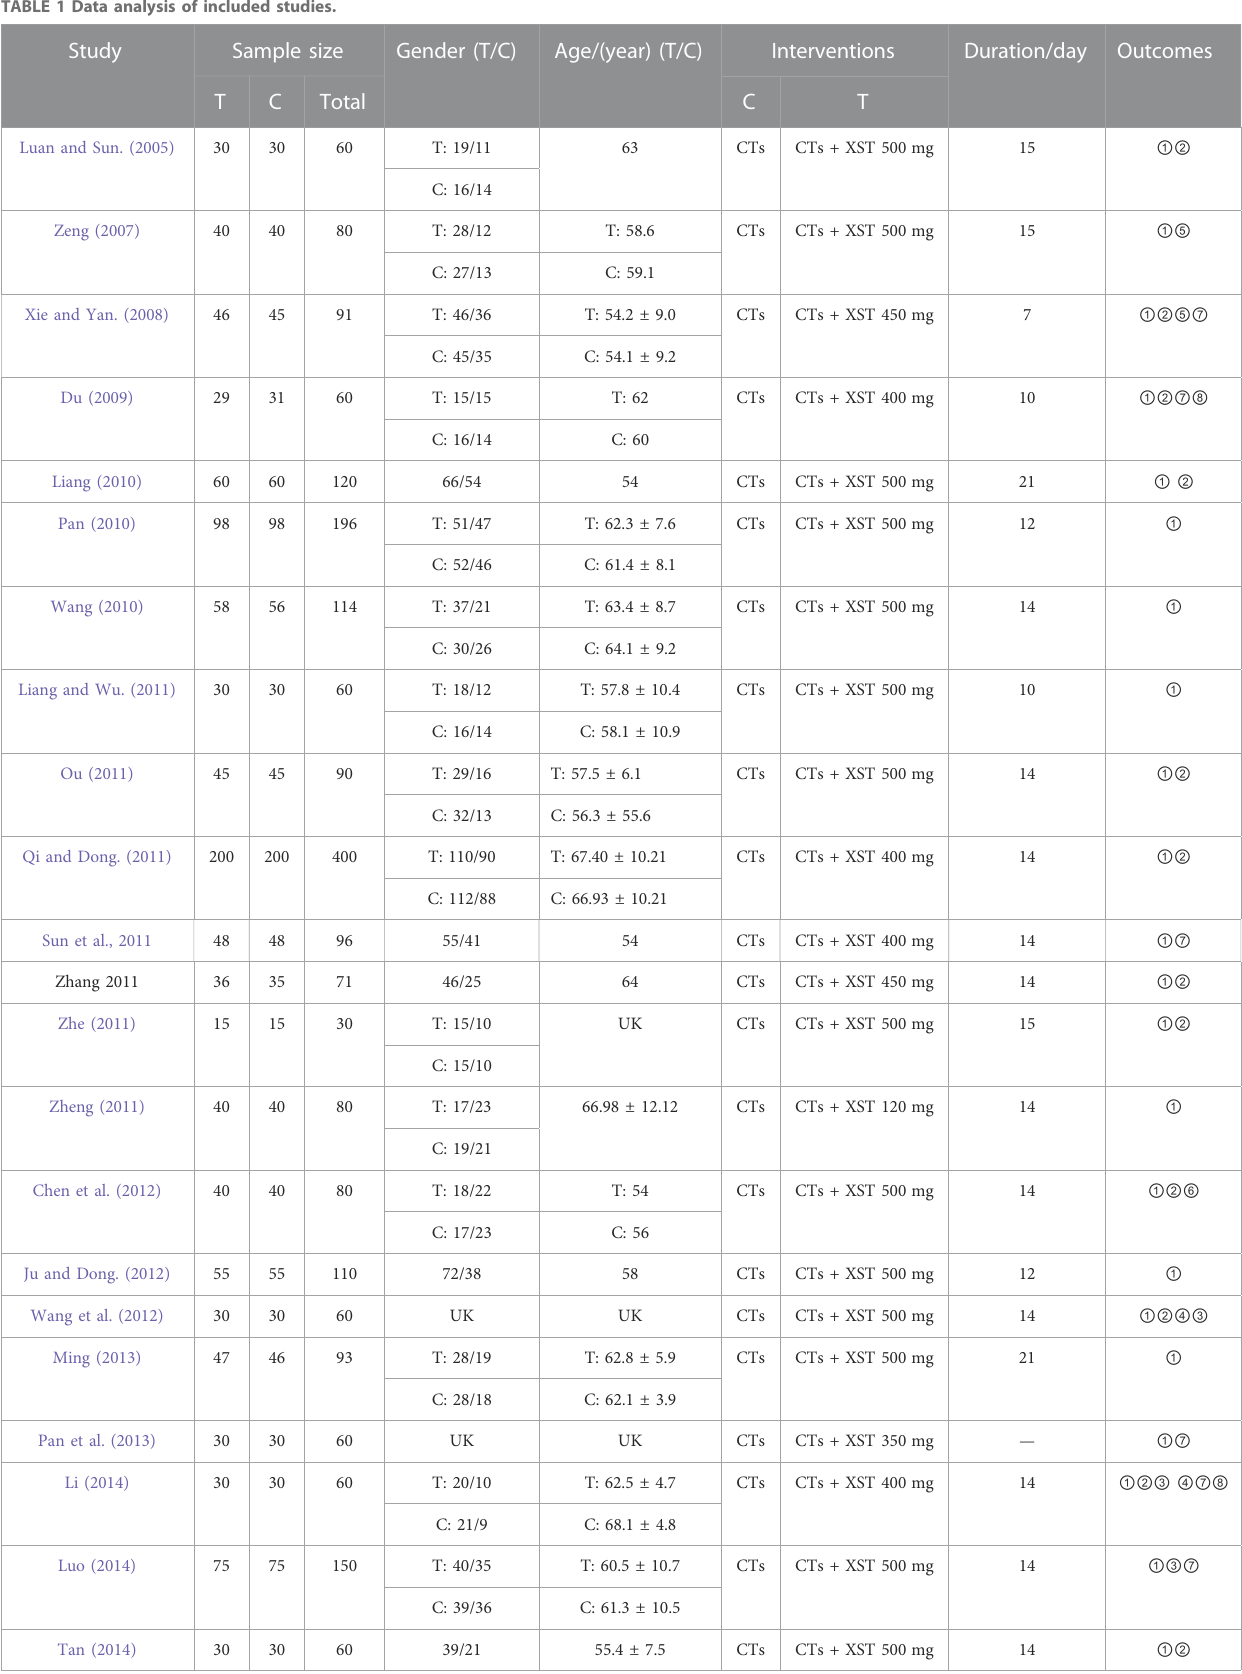
TABLE 1 Data analysis of included